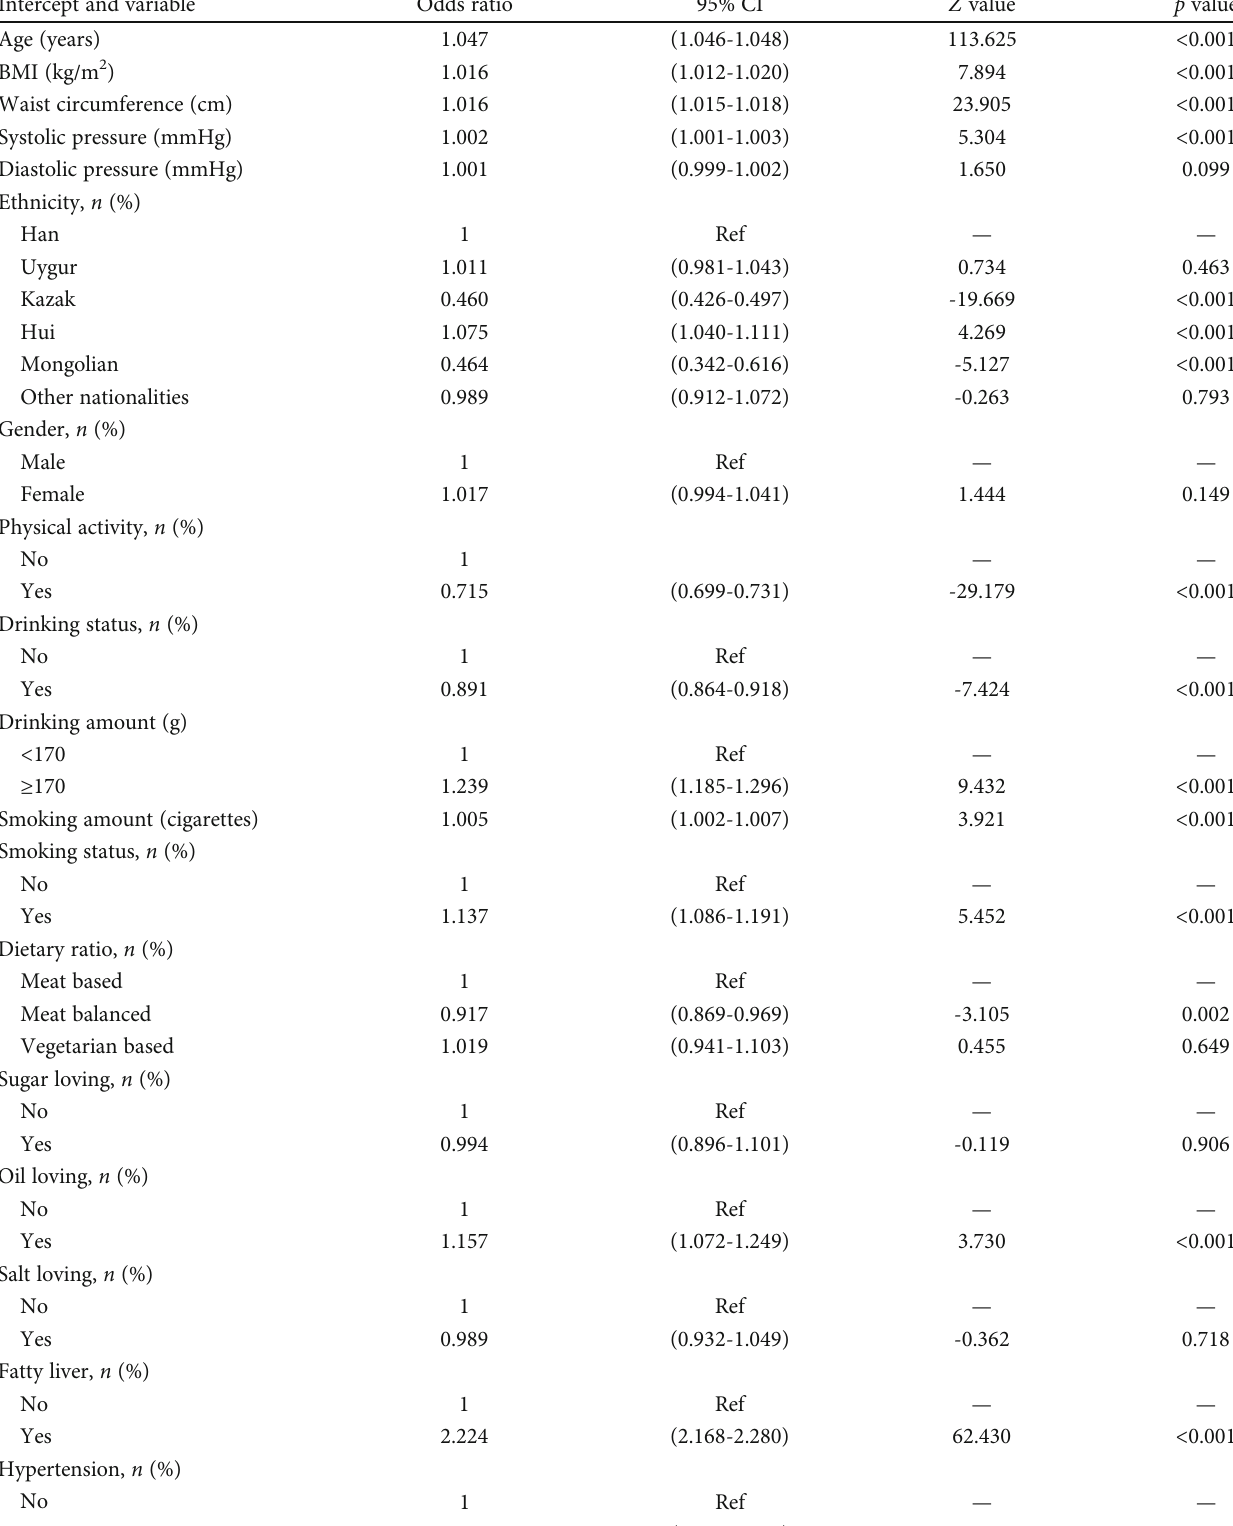
Table 2: Screening the risk factors for T2DM by multiple logistic regression (CI =con fi dence